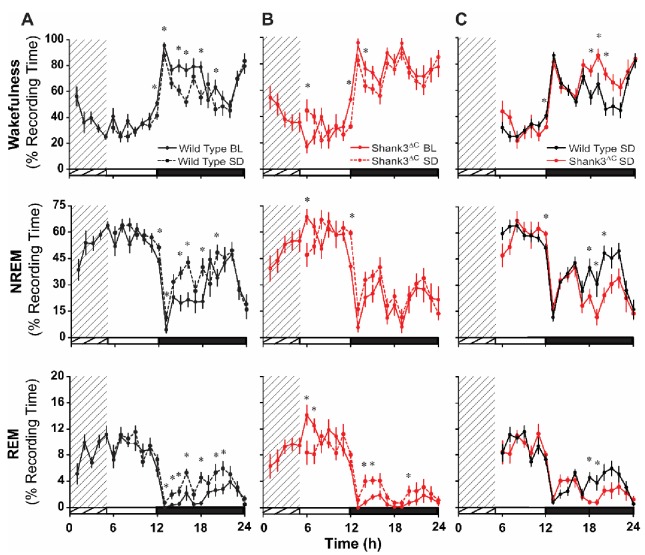
Shank3∆C mice sleep less than wild type after sleep deprivation.The rows represent the vigilance states of wakefulness (top), NREM sleep (middle), and REM sleep (bottom). (A – B) Time in state shown as percentage of recording time per hour comparing baseline and sleep deprived conditions for wild type mice (A) and Shank3∆C mice (B). Repeated measures ANOVA with posthoc pairwise comparisons using Sidak correction; *p<0.05, difference from baseline. (C) Time in state shown as percentage of recording time per hour after sleep deprivation. Repeated measures ANOVA with posthoc pairwise comparisons using Sidak correction; *p<0.05, difference from wild type. The cross-hatching for hours 1–5 denotes the 5 hr sleep deprivation period, the open bars on the x-axis denote the light period, and the filled bars on the x-axis denote the dark period of the light:dark cycle. Values are means ± SEM for wild type (n = 10) and Shank3∆C (n = 10) mice.